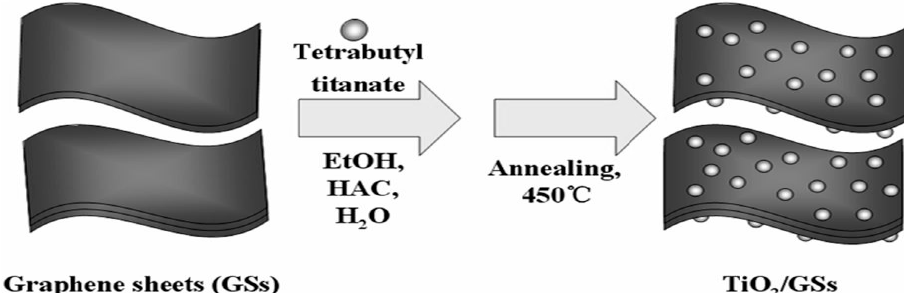
Figure 8. Schematic diagram of the sol-gel preparation of TiO 2 /GO nanocomposites. Reprinted with permission from reference [133]. Copyright 2010 Royal Society of Chemistry.